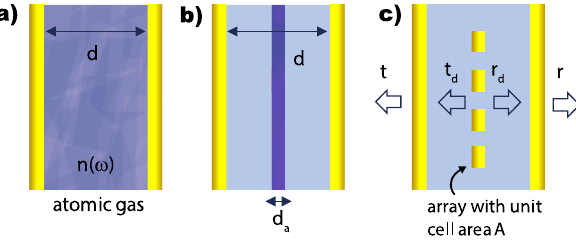
Figure 7: (a) Sketch of an etalon entirely filled with a dispersive medium with refractive index n ( ω ) . (b) Etalon in which all polarizable material from (a) is bunched into a slab of thickness d a . (c) Etalon in which the perturbation is viewed as a strongly dispersive re fl ector , essentially transforming the system into two coupled cavities coupled through a partially transparent membrane in the middle. A metasurface is a strongly dispersive membrane. t d ( r d ) and t ( r ) are transmission (re fl ection) coef fi cients of the center mirror and the outer mirrors respectively. Importantly, both case (b) and (c) show strong coupling, but (c) cannot be described as the limit d a → 0 of panel (b), i.e., a metasurface cannot be consistently viewed as the limit of an increasingly thin but polarizable